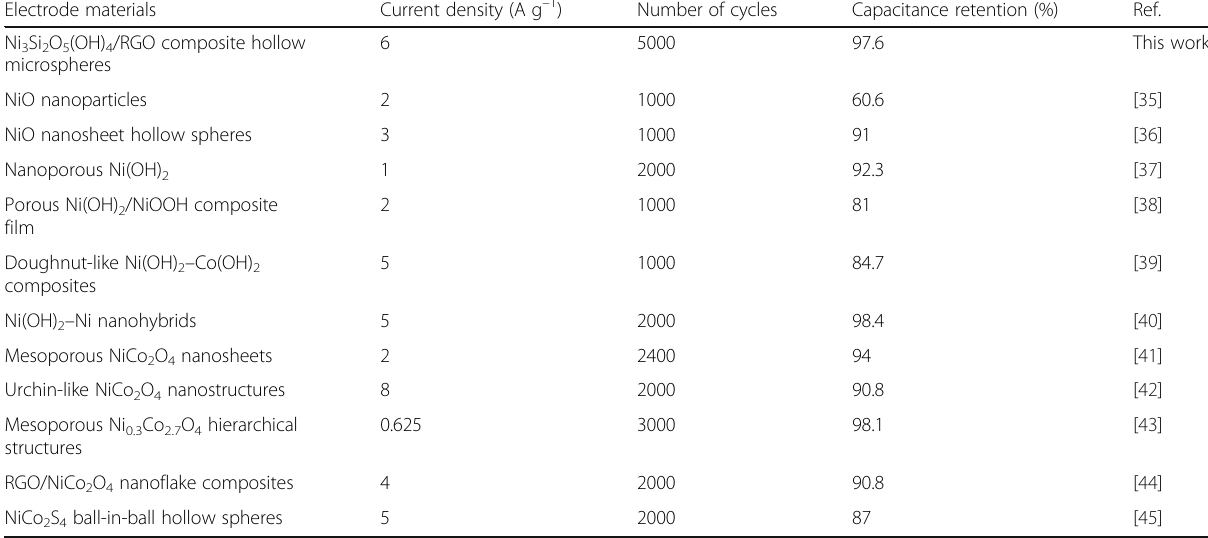
Table 1 Comparison of cycling stability between Ni 3 Si 2 O 5 (OH) 4 /RGO composite hollow microspheres and some of other reported nickel-based electrode materials. All these data were obtained in three-electrode systems Electrode materials Current density (A g – 1 ) Number of cycles Capacitance retention (%)